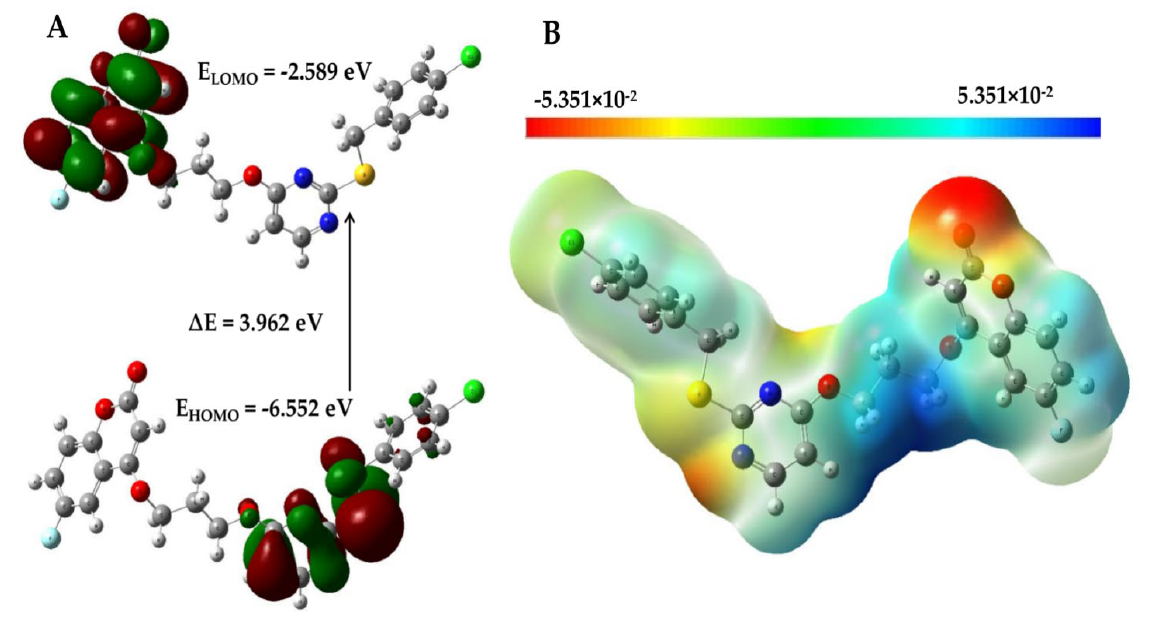
Figure 5. Computed molecular orbital ( A ) and electrostatic charge distribution ( B ) plots for PC-12. Colors on the surfaces of the atoms indicate different electrostatic potentials, with electrostatic potential value increasing in the following order: red < orange < yellow < green < blue.